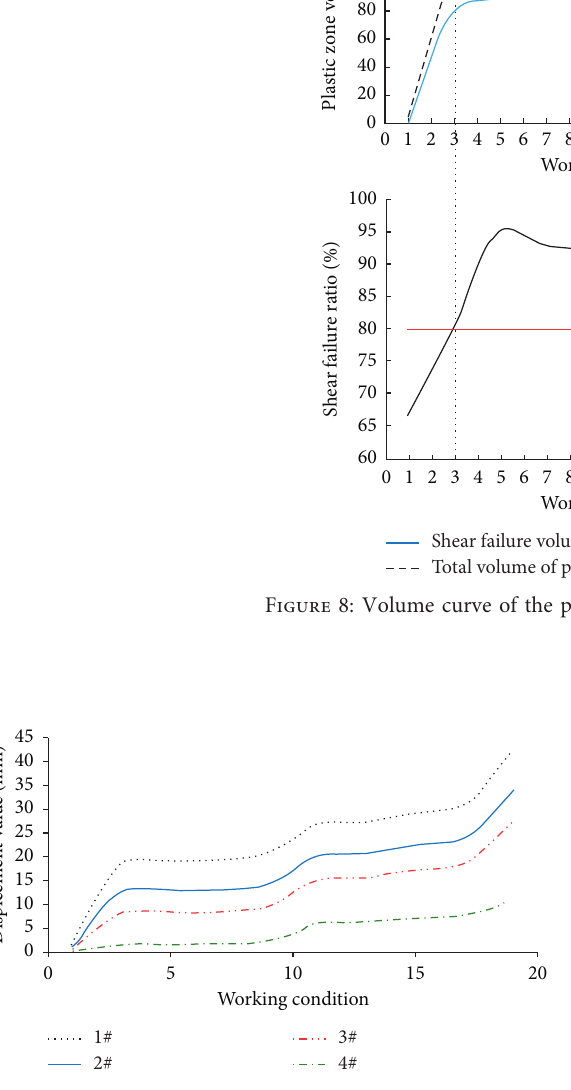
Figure 9: Vertical displacement curve of each measuring point.